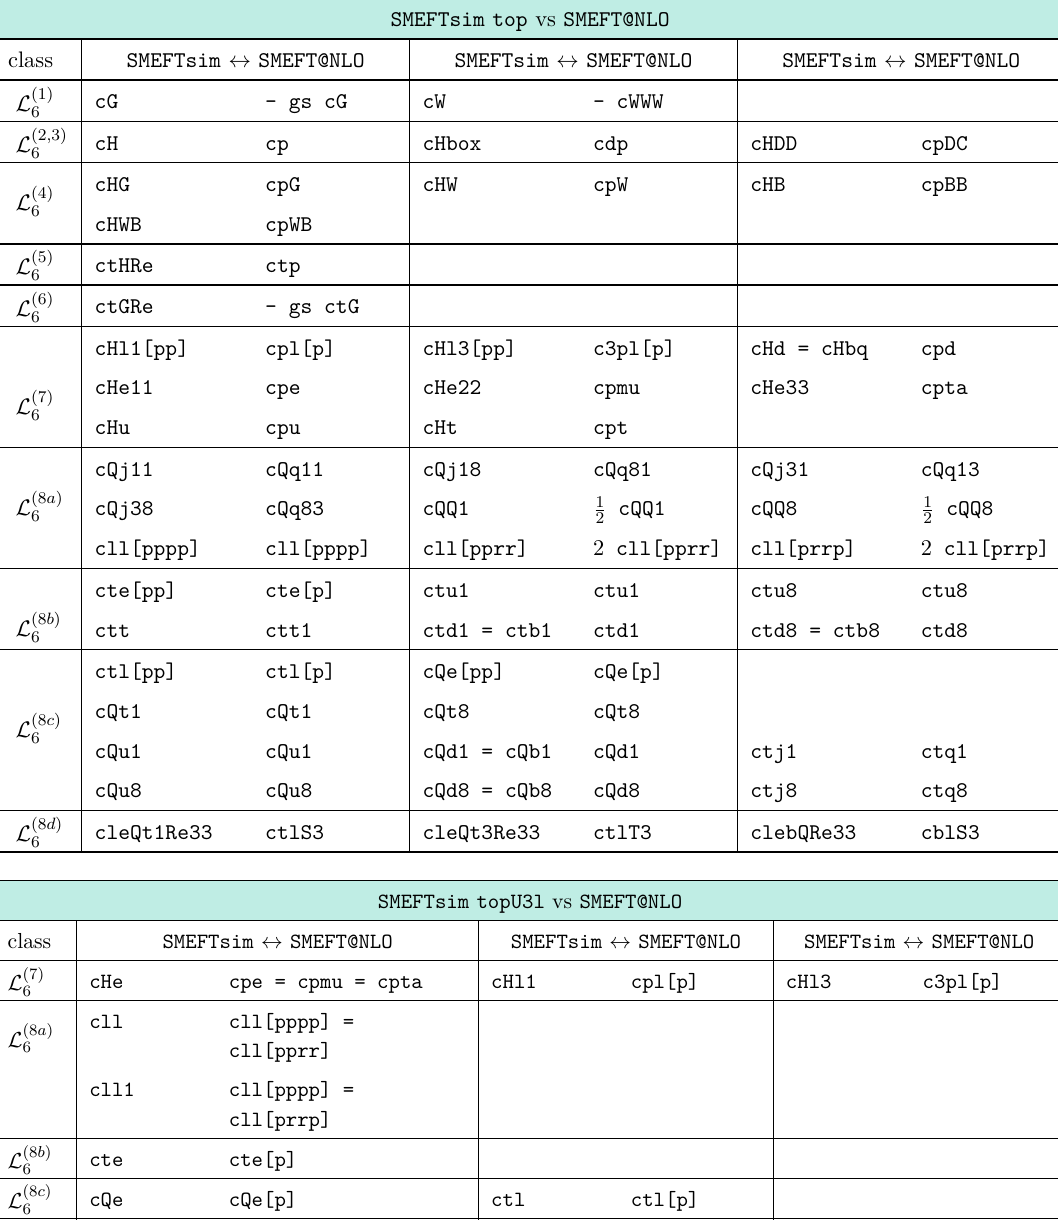
Table 28 . Upper panel: conversion table between the SMEFT parameters defined in the top version of SMEFTsim and in SMEFT@NLO v1.0 , for parameters that have a one-to-one translation. Lower panel: conversion table between the topU3l version of SMEFTsim and SMEFT@NLO . Only leptonic coefficients are reported, as the other parameters behave identically to the top case. The = sign indicates that all parameters need to be fixed to the same value. Lepton flavor indices p take values p,r = { 1,2,3 }